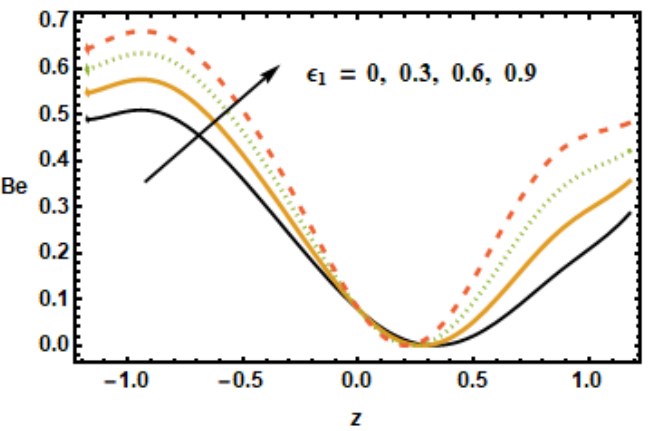
Figure 30. Effects of heat